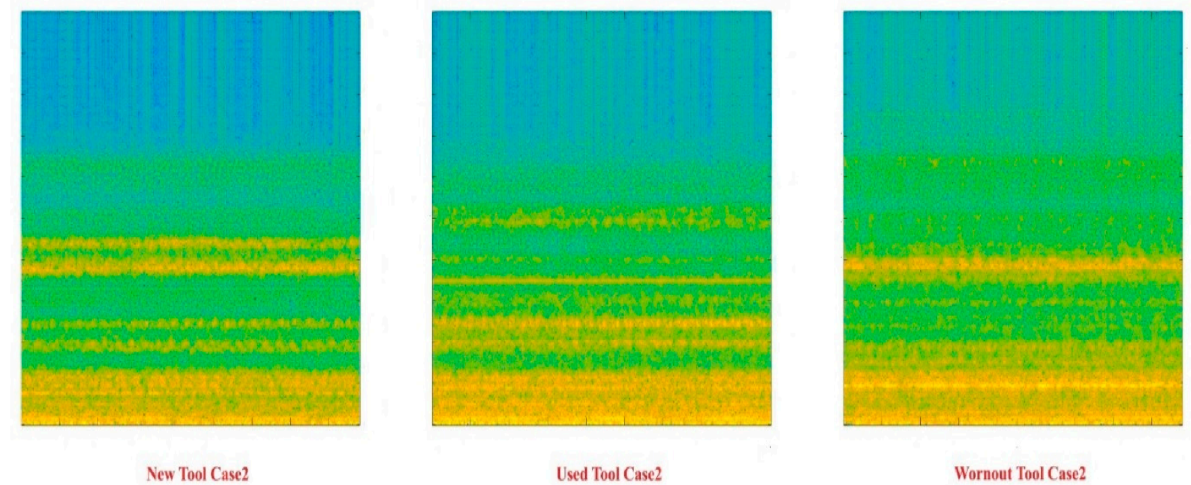
Figure 22. Spectrograms (training samples) of new, used, and worn-out tool conditions for Case 1.